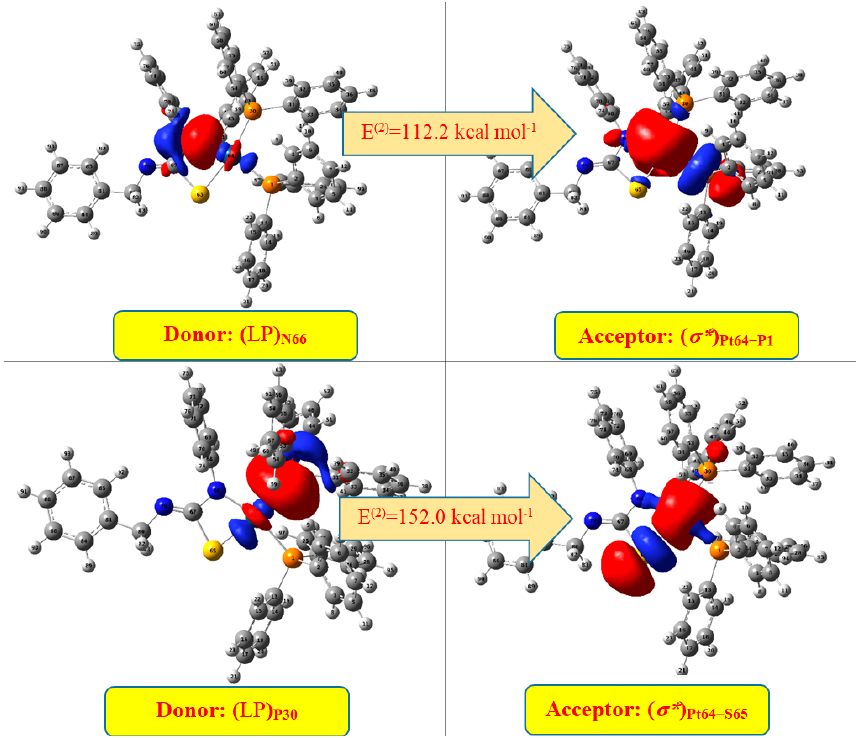
Figure 5. Donor and acceptor orbitals of two highest second-order perturbation energies (E (2) ) of [Pt(BPT)(PPh 3 ) 2 ] ( 5 ) complex.